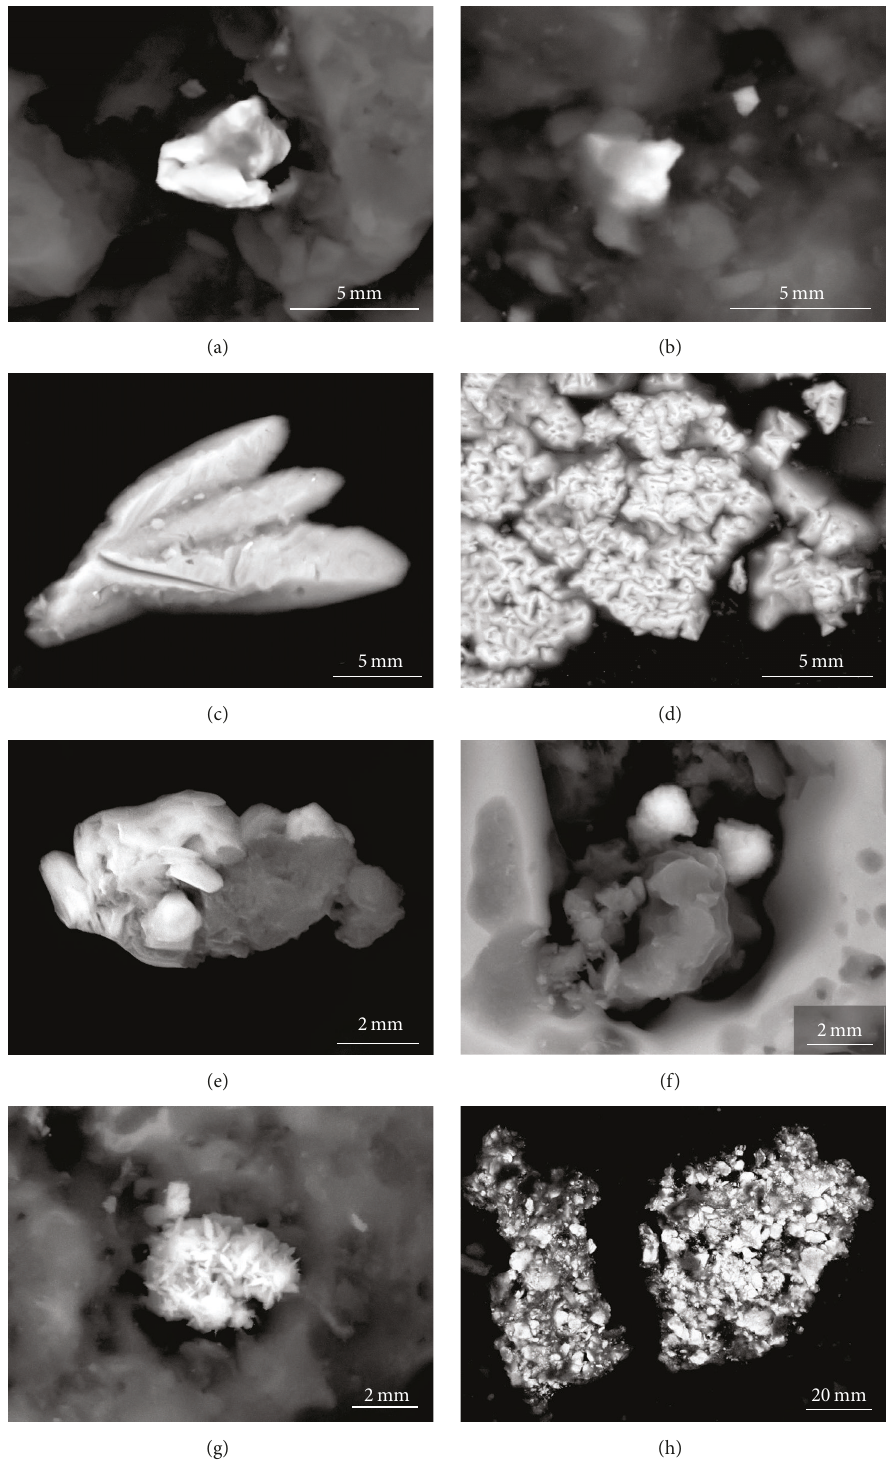
Figure 7: Rare phases from fumarolic incrustations of Ebeko volcano. (a) Small aggregate of palladian gold attached to sulfur surface. (b) Aggregate and a single crystal of cadmoindite (CdIn 2 S 4 ) on sulfur surface. (c) Aggregate of argentite (Ag 2 S) crystals. (d) Aggregate of cinnabar (HgS) crystals. (e) Crystals of (NH 4 )As 4 O 6 I (white) attached to sulfur (gray). (f) Two globules of famatinite (Cu 3 SbS 4 ) (white) surrounded by sulfur (light gray) and alunite (gray). (g) Aggregate of Cu-Sn sulfide (white) on sulfur surface (gray). (h) Aggregate of cotunnite (PbCl 2 ) (white crystals) mixed with silicate particles. SEM BSE